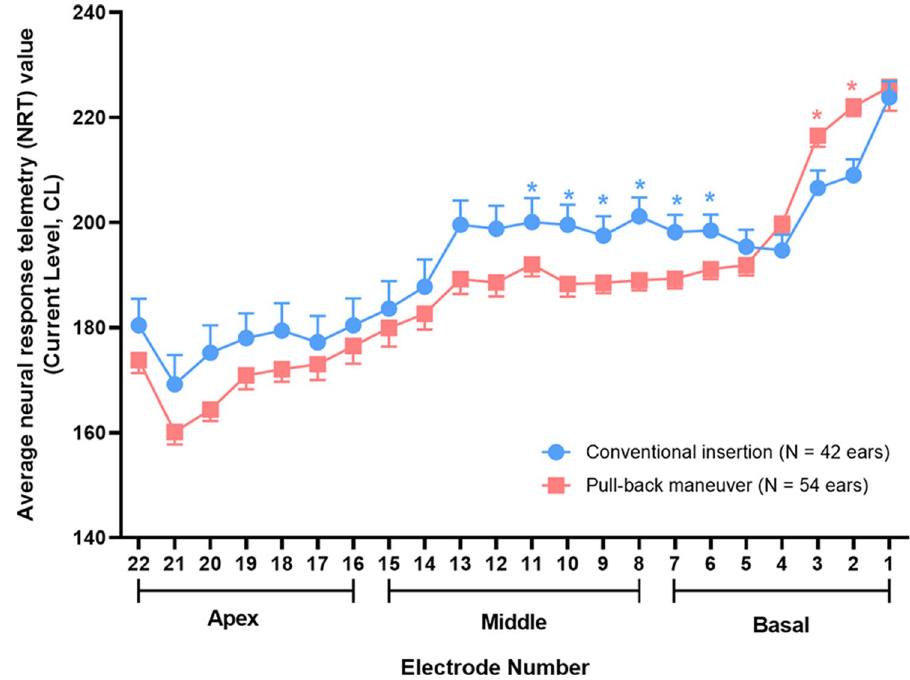
Figure 3. Intraoperative electrically evoked compound action potential (ECAP) thresholds according to insertion techniques. Using the pull-back maneuver-assisted insertion, the average ECAP thresholds of electrode channel is significantly lower, especially in the upper basal and middle cochlear region (Electrode 6–Electrode 12), as compared those using the conventional insertion. In contrast, the pull-back maneuver-assisted insertion led to significantly higher ECAP thresholds in the basal cochlear electrode channels (Electrode 2–Electrode 3) than with conventional insertion. Data are means ± standard error of mean (SEMs), * P < 0.05 by independent